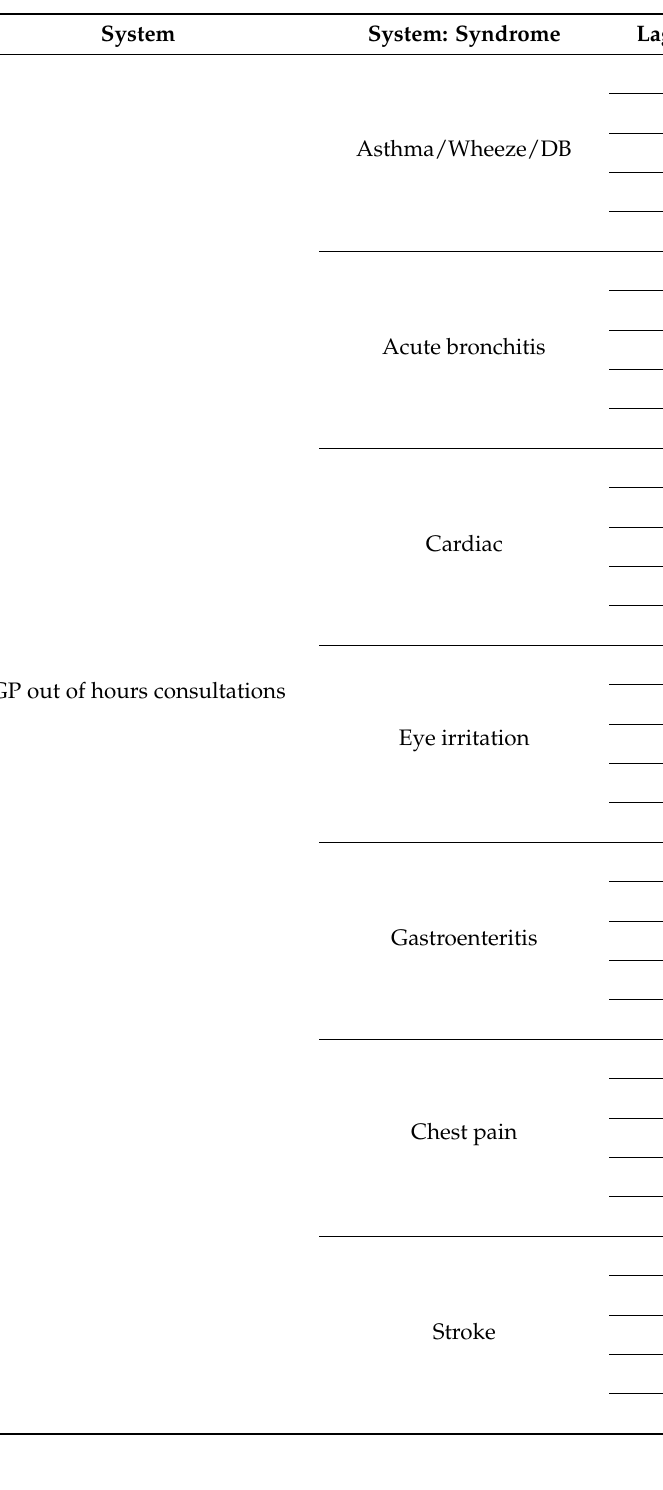
Table A3. Meta analysis results—estimate of rate ratios for direct effect of air pollution on syndromic indicators, all lags. Results where lower 95% confidence interval is at least 1 are highlighted in